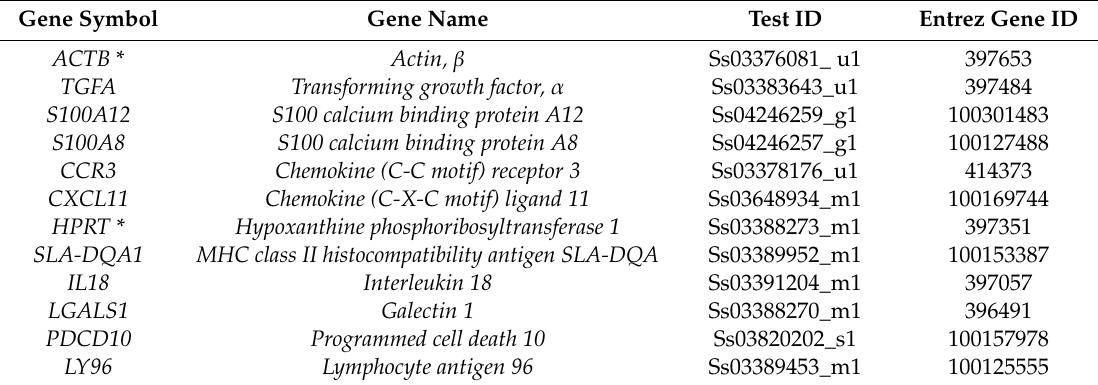
Table 1. TaqMan assays used for real-time PCR validation of microarray